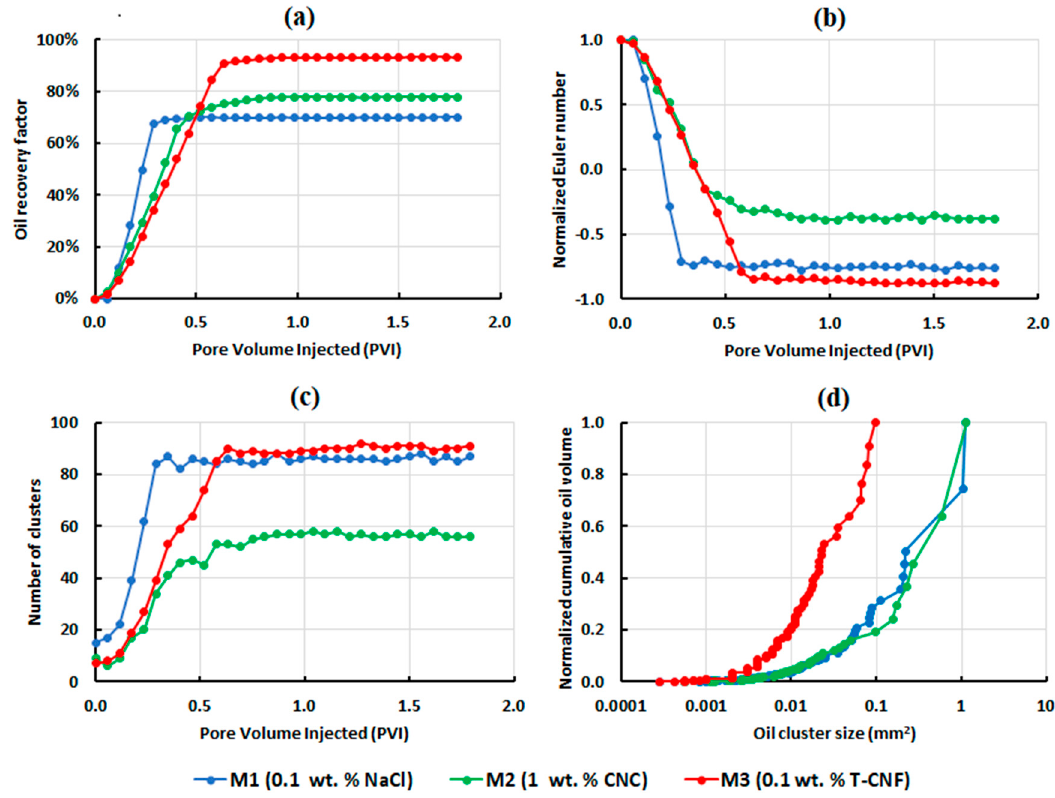
Figure 9. Results for the low rate injection microfluidic experiments: ( a ) oil recovery factor; ( b ) normalized Euler number; ( c ) number of clusters versus pore volume injected; and ( d ) normalized cumulative residual oil volume, as a function of oil cluster size.